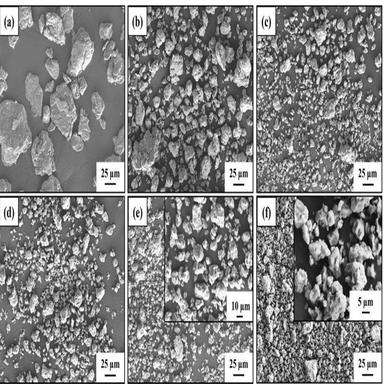
SEM images of powder mixture mechanically alloyed for (a) 10 h, (b) 20 h, (c) 30 h, (d) 40 h, (e) 50 h, (f) 60 h.